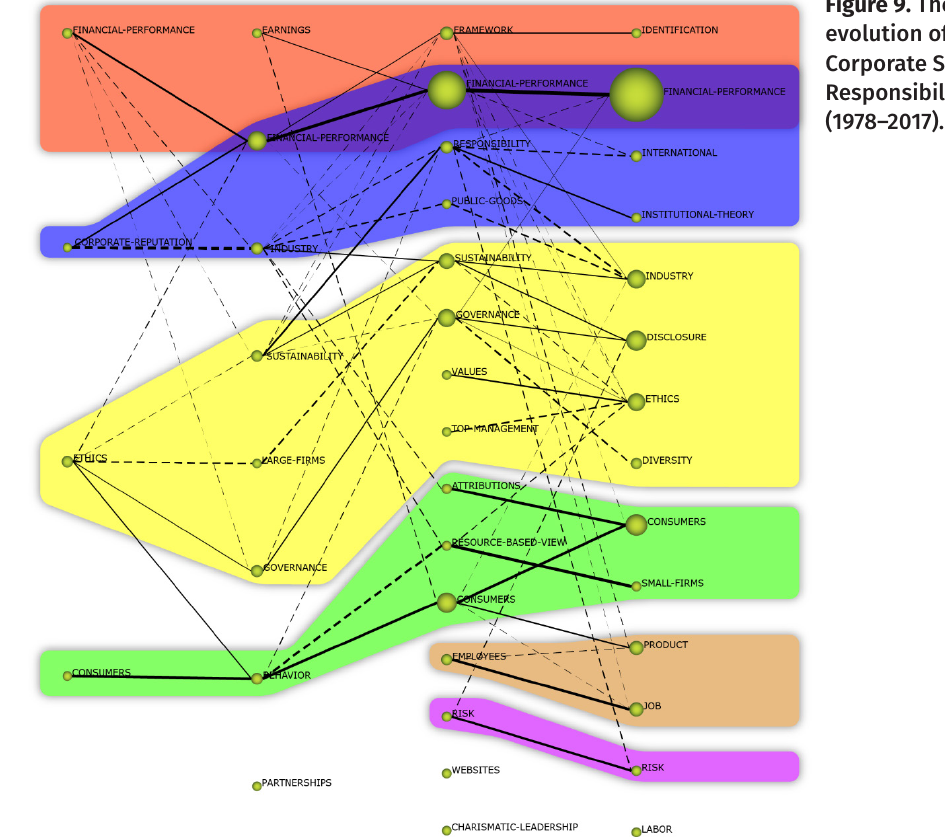
Figure 9. Thematic evolution of